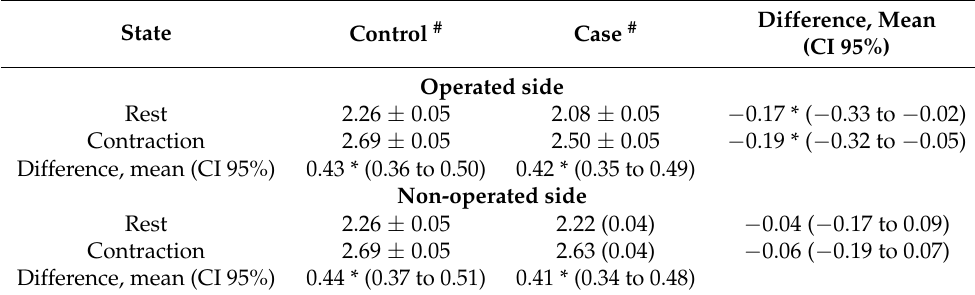
Table 3. Differences adjusted for muscle thickness.